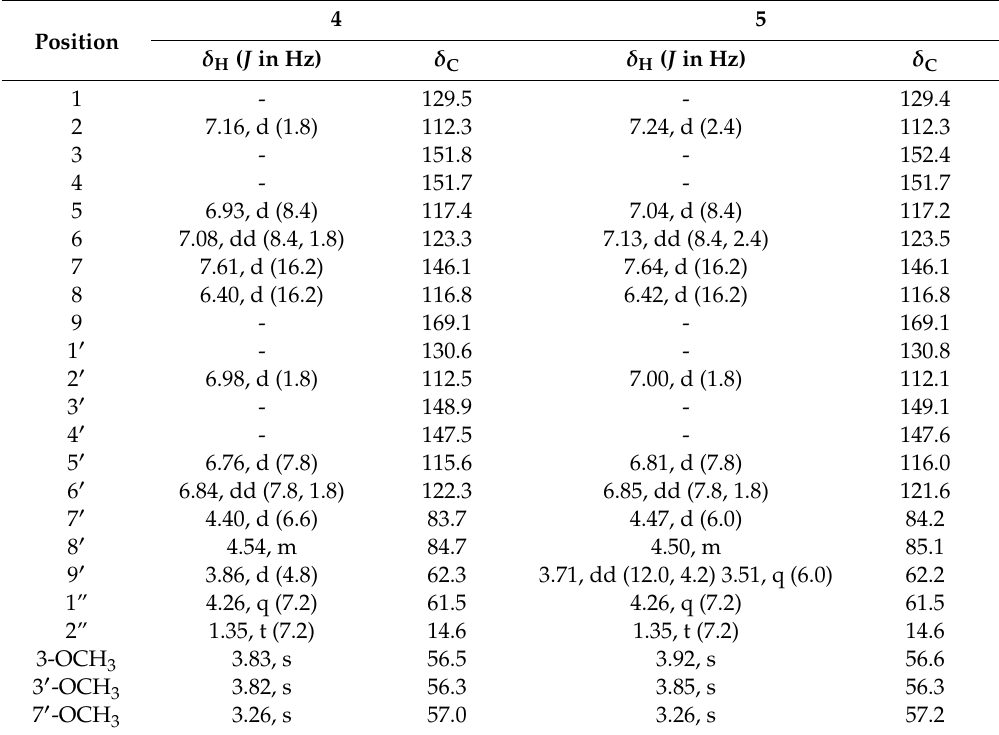
Table 2. 1 H NMR data (600 MHz) and 13 C NMR data (150 MHz) of compounds 4 – 5 (CD 3 OD).